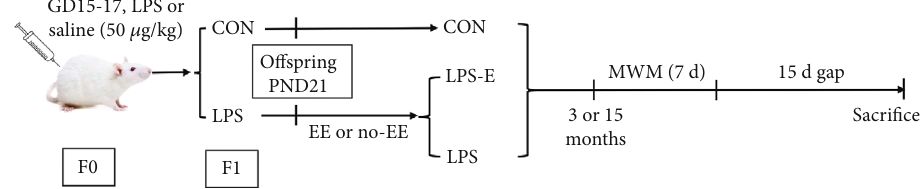
Figure 1: The timeline of experimental events. GD15-17: gestation 15-17 day; CON: untreated control group; LPS: lipopolysaccharide treatment group; E: group of mice exposed to EE; MWM: Morris water